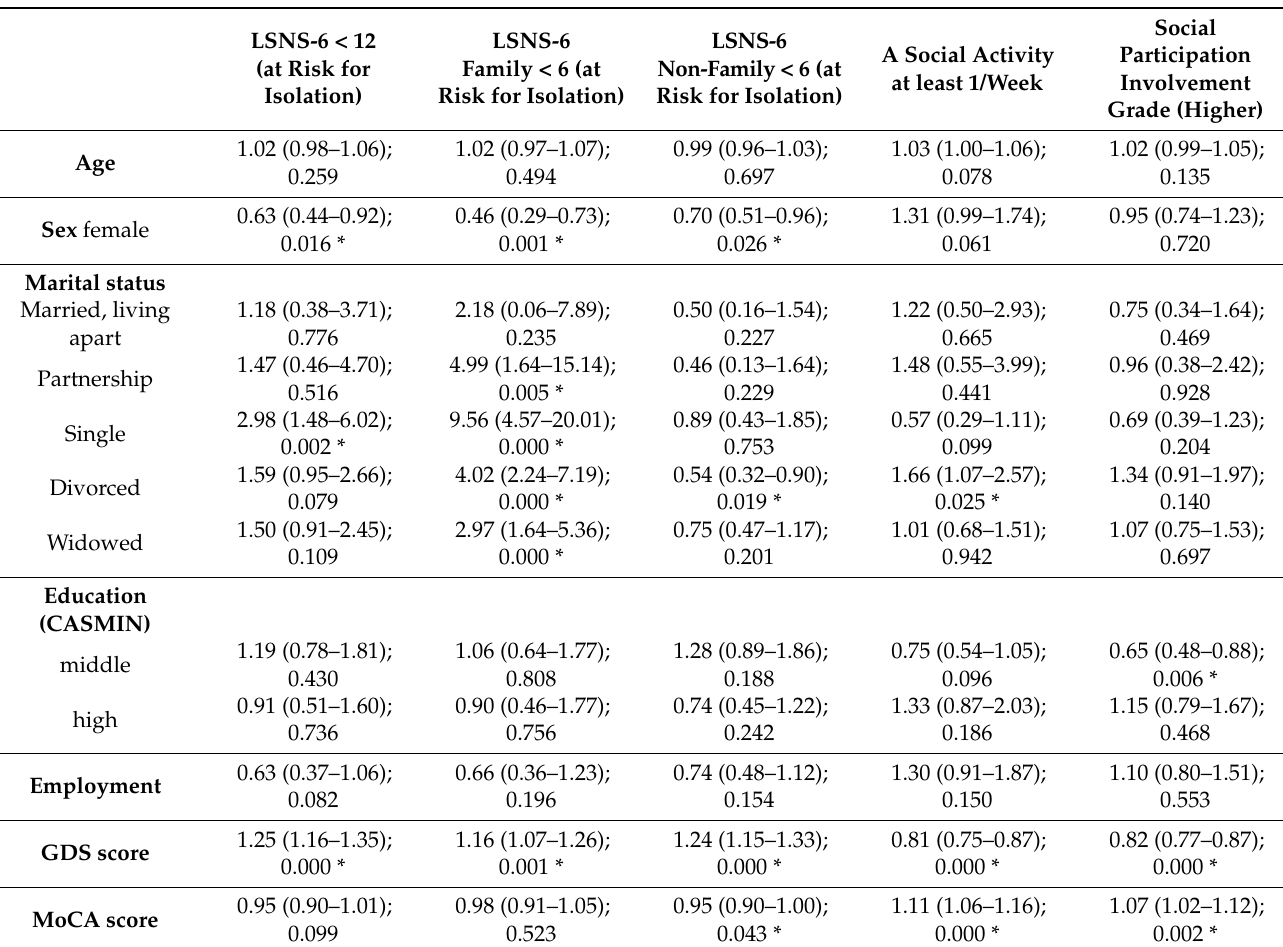
Table 2. Multivariate analyses (logistic regression) OR (95% CI); p